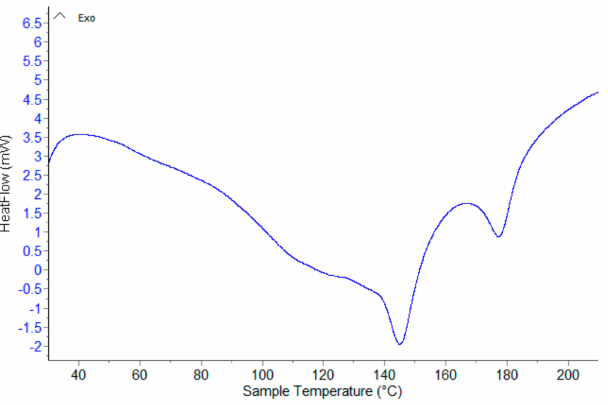
Figure A6. The DSC thermogram of RUT- β -CD complex, dynamic nitrogen atmosphere, β = 10 K min − 1 .